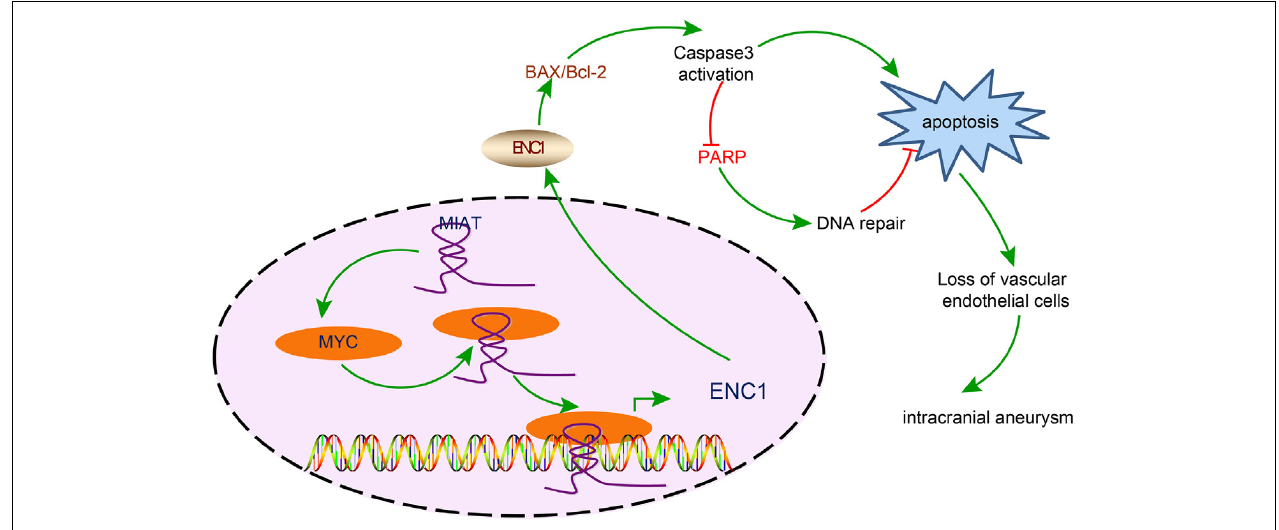
FIGURE 7 | The mechanism diagram illustrating the effects of the MIAT/MYC/ENC1 axis on endothelial cell apoptosis in IA. MIAT enhanced the expression of ENC1 through MYC, thereby promoting vascular endothelial cell apoptosis and further inducing the pathogenesis of